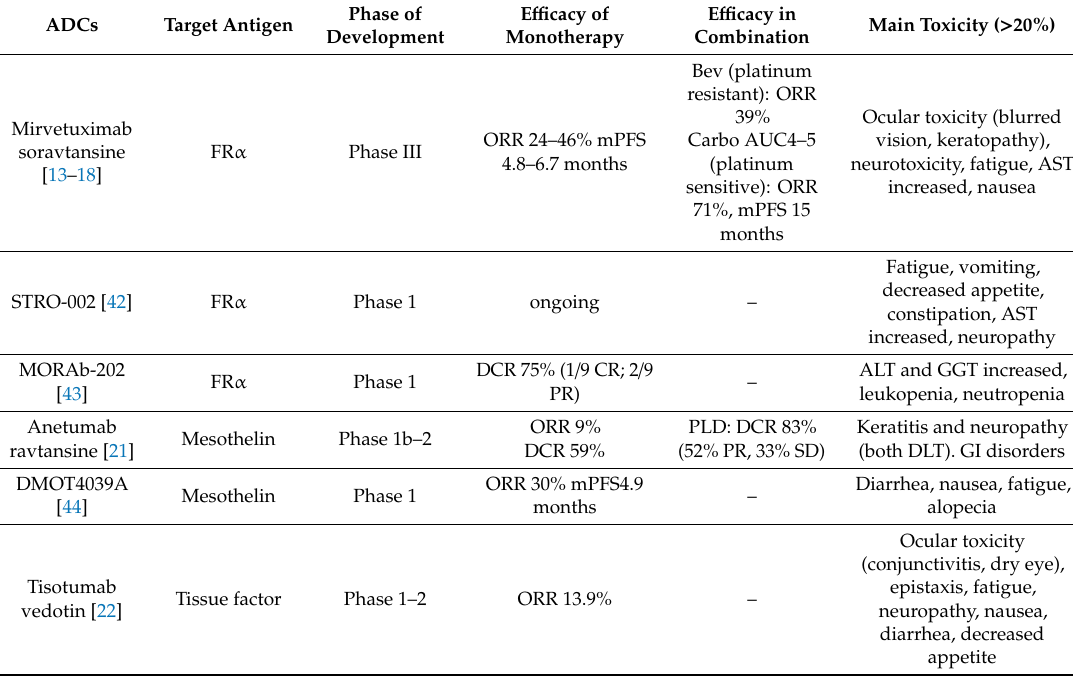
Table 3. Clinical e ffi cacy of ADCs in ovarian